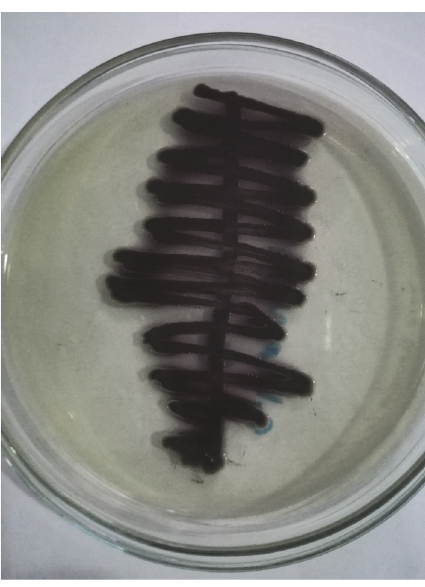
Figure 1: Colonies of Chromobacterium violaceum in cystine lactose electrolyte deficient agar.